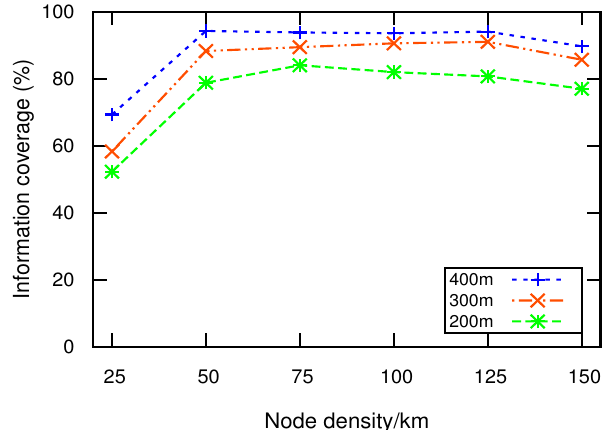
Figure 9. Information coverage vs. node density.